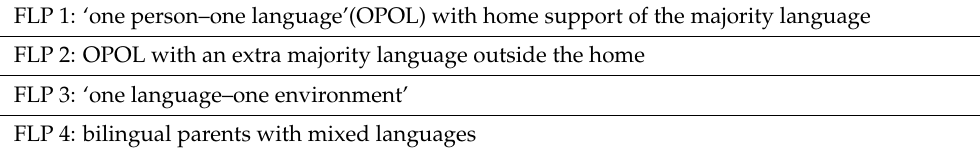
Table 1. Family language policies (adapted from Arnaus Gil et al. 2020, p.